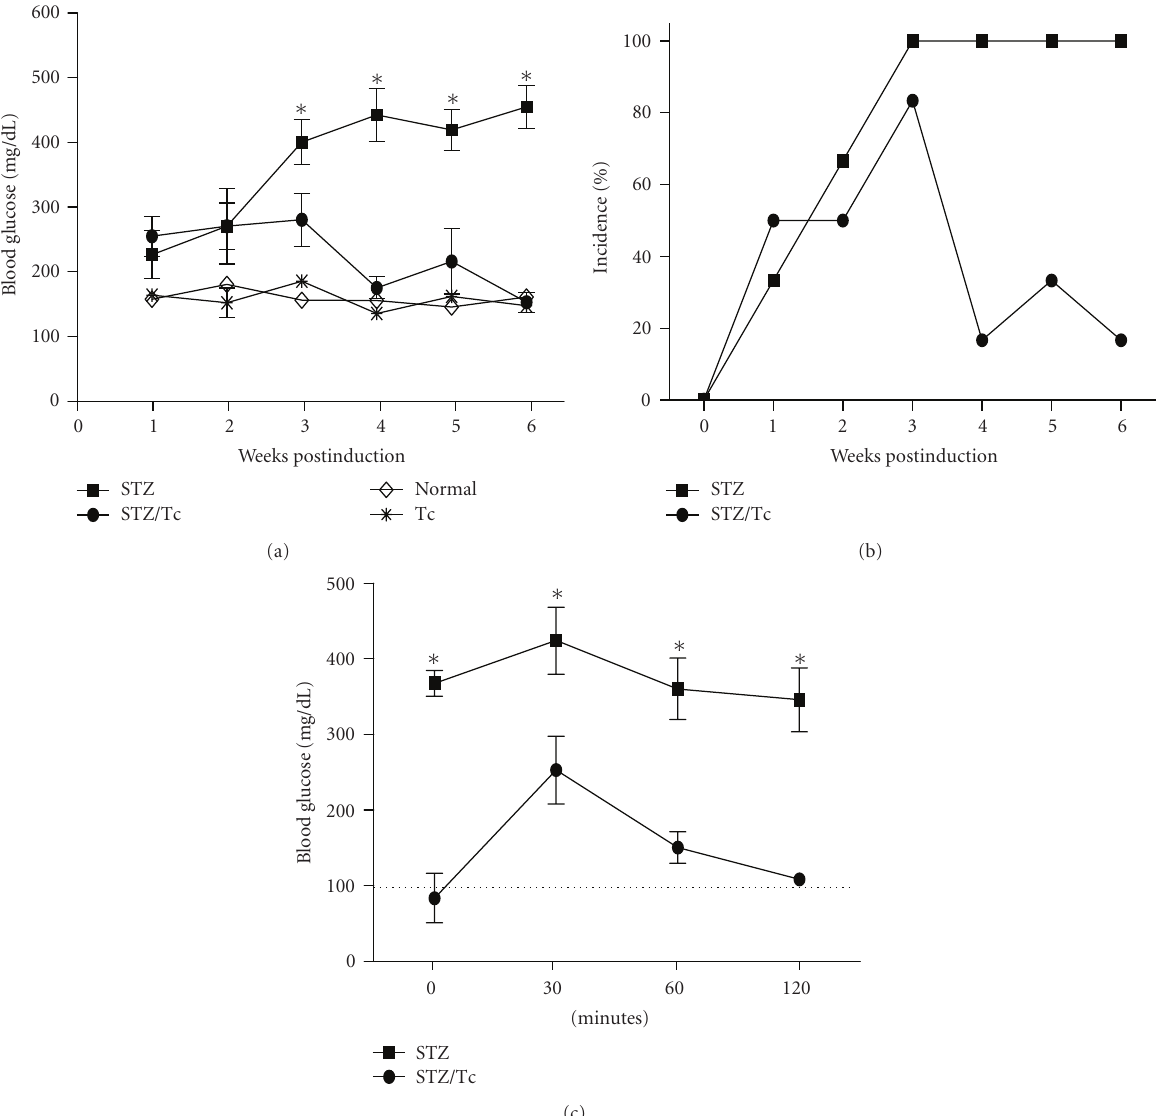
Figure 2: Hyperglycemia and diabetes incidence is modified by T. crassiceps infection in C57BL/6 mice. (a) Blood glucose levels throughout the MLDS protocol for uninfected C57BL/6 mice and mice infected with T. crassiceps for 6-weeks. (b) Percent incidence of diabetes between uninfected and T. crassiceps -infected C57BL/6 mice. (c) Intraperitoneal glucose tolerance test for MLDS-treated uninfected and T. crassiceps- infected mice. ∗ P < . 05, n =